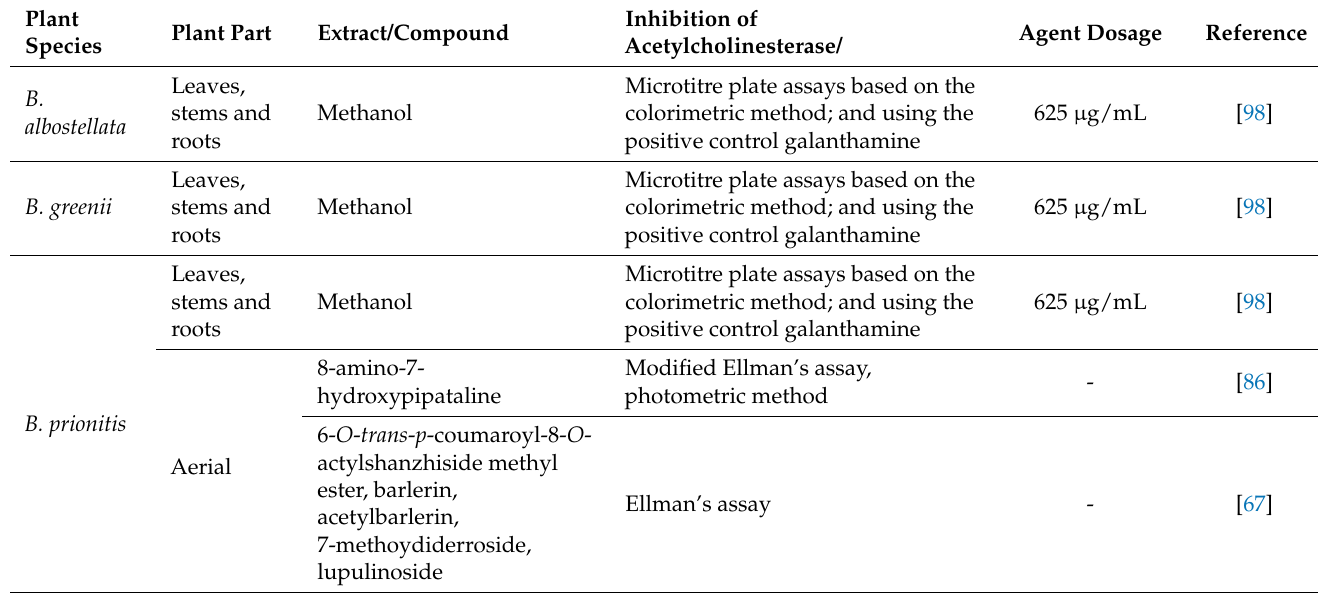
Acetylcholinesterase inhibition of extracts and isolated compounds from species within Barleria